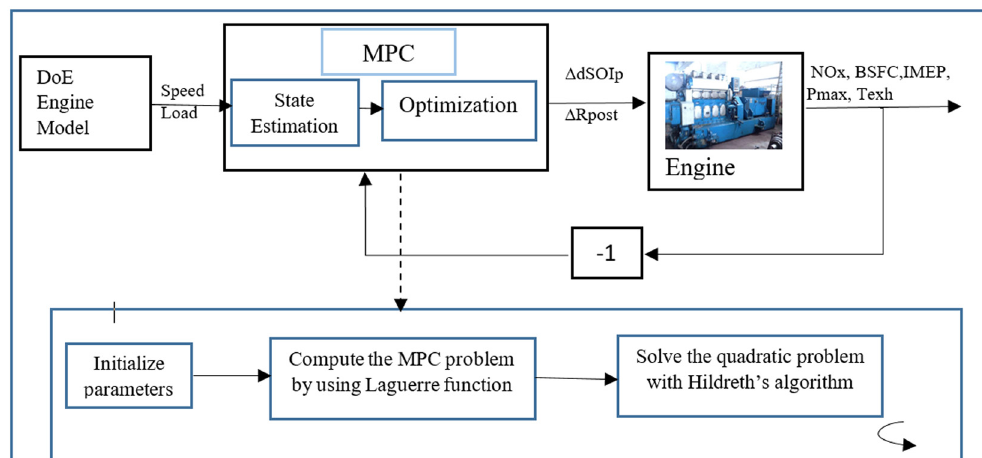
Figure 2: MPC implementation structure.